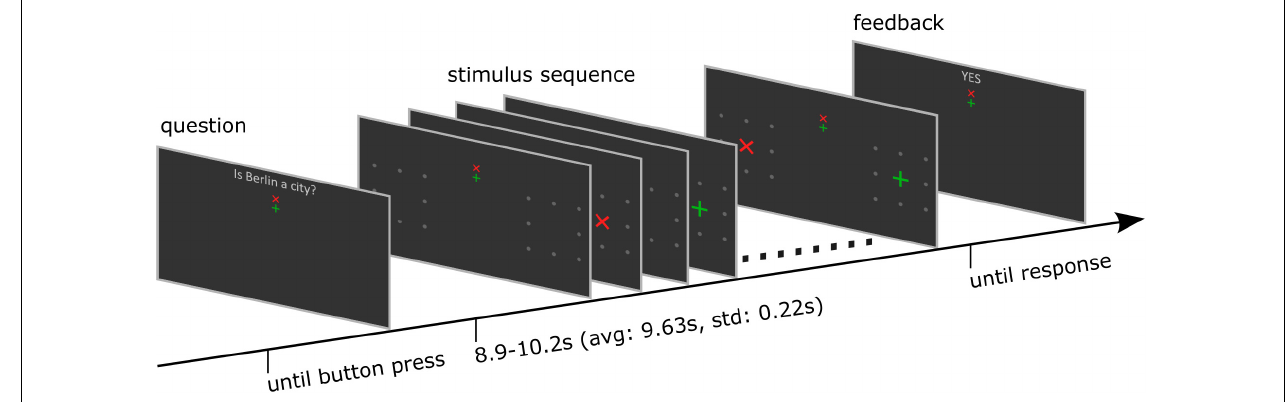
FIGURE 1 | Structure of one trial. The trial started with a dichotomous question. The participant started the stimulation sequence by button press. After the stimulus presentation was finished, the BCI determined the target symbol, and the corresponding feedback was presented. Finally, participants indicated its correctness by responding with a further button press. See also the Supplementary Material for a video demonstration.